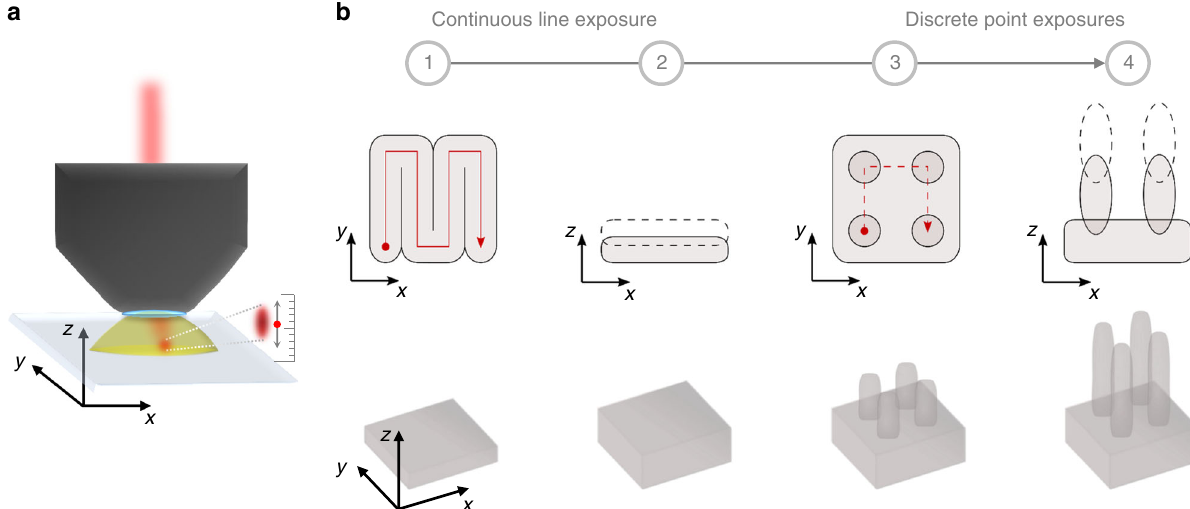
Fig. 6 Fabrication process for holographic colour pixels. a In the direct laser writing exposure process, a 780 nm femtosecond pulsed IR laser beam is focused into a liquid puddle of negative-tone photoresist. At the focal point of the laser spot, the UV-sensitive photoresist is cross-linked by two-photon polymerisation and becomes solid. (Unexposed photoresist remains as a liquid and is later washed away during development.) The laser spot is translated in three dimensions ( x , y , and z ) according to the sequence in b to create complex structures. Resolution in the z -direction is not limited by the axially elongated shape of the point spread function as it is determined by the positioning accuracy of the laser spot. b Process fl ow for fabricating a holographic colour pixel using direct laser writing: (1) Blocks are created by rastering the laser spot to fi ll a square in the xy -plane with a continuous line exposure (hatching); (2) Step 1 is optionally repeated at higher z -positions to give thicker blocks (slicing); (3) Pillar arrays are created by point exposures, where the diameter is controlled by the exposure dose; (4) Step 3 is optionally repeated at higher z -positions to give taller pillars. Block thickness and pillar height are controlled in Steps 2 and 4 by overlapping multiple layers of exposures along the z -direction. A full holographic colour print is made by patterning an array of many pixels with different block thicknesses and pillar